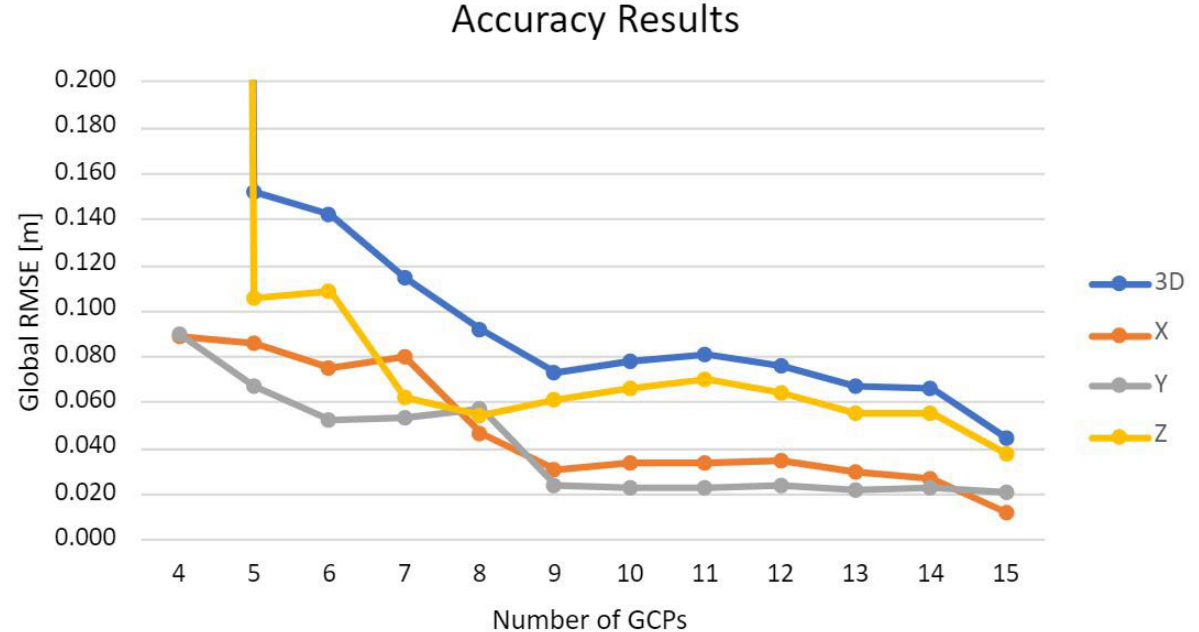
Figure 4. Summary of Accuracy Results